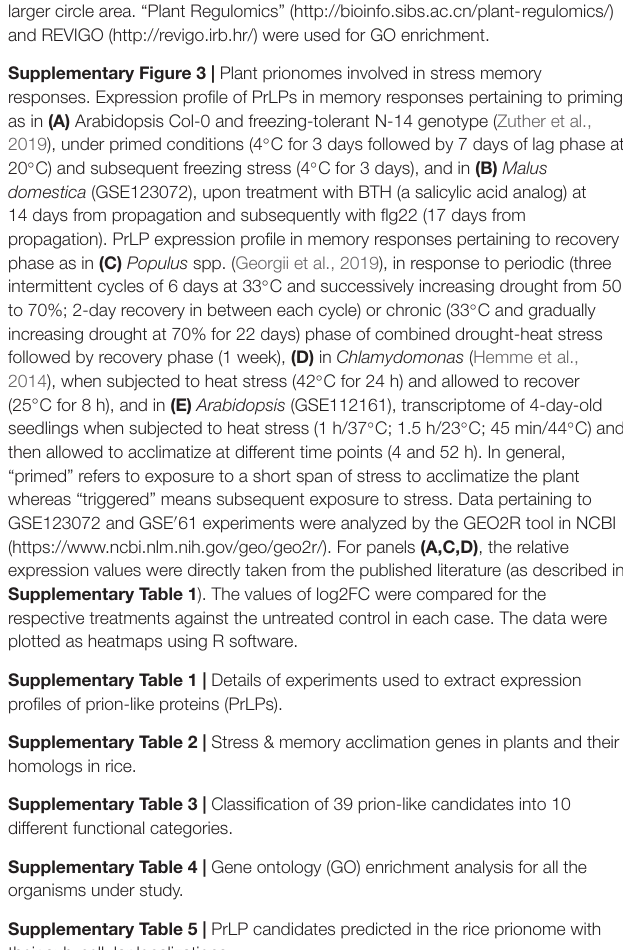
Supplementary Figure 2 | Gene ontology (GO) enrichment analysis of rice PrLPs. The y -axis represents different GO entries belonging to three categories viz. biological processes (BP), cellular components (CC), and molecular functions (MF). The x -axis represents the values of p (log10 scale) of the unique GO entries. The circle size indicates the frequency of the terms. The more general terms have a larger circle area. “Plant Regulomics” (http://bioinfo.sibs.ac.cn/plant-regulomics/) and REVIGO (http://revigo.irb.hr/) were used for GO enrichment. Supplementary Figure 3 | Plant prionomes involved in stress memory responses. Expression profile of PrLPs in memory responses pertaining to priming as in (A) Arabidopsis Col-0 and freezing-tolerant N-14 genotype (Zuther et al., 2019), under primed conditions (4 ◦ C for 3 days followed by 7 days of lag phase at 20 ◦ C) and subsequent freezing stress (4 ◦ C for 3 days), and in (B) Malus domestica (GSE123072), upon treatment with BTH (a salicylic acid analog) at 14 days from propagation and subsequently with flg22 (17 days from propagation). PrLP expression profile in memory responses pertaining to recovery